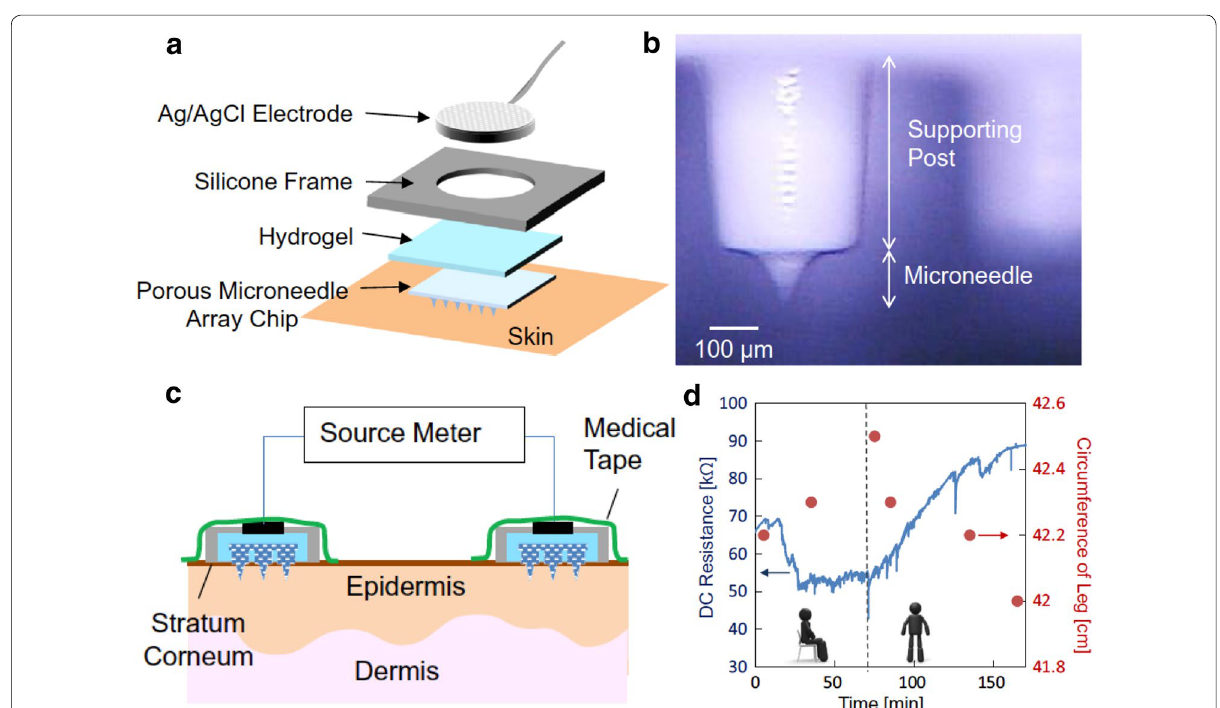
Fig. 4 a Schematic of the porous MN-based intercellular swelling measurement system. b A micrograph of the porous PEG MN. c Schematic of the DC resistance measurement by two porous MN array. d The DC resistance measured by the porous MN array and the circumference changed by